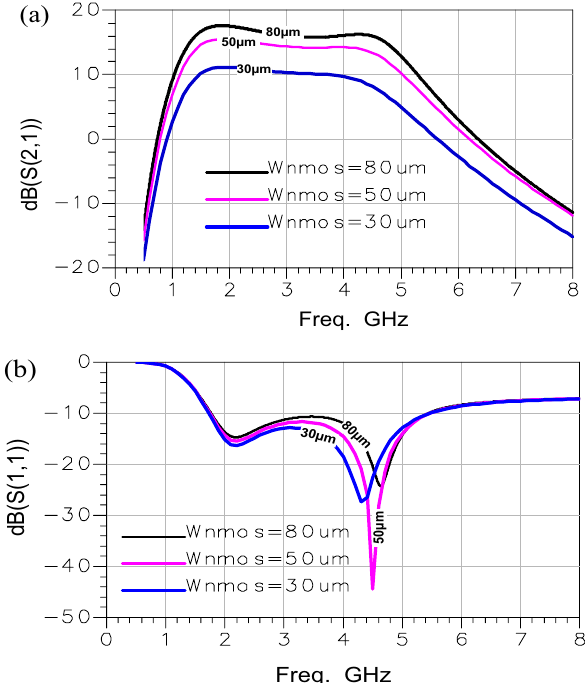
Figure 6. ( a ) Gain curve (S(2,1)), ( b ) Input reflection coefficient curve (S(1,1)): for different NMOS transistorwidth (W NMOS ) values.